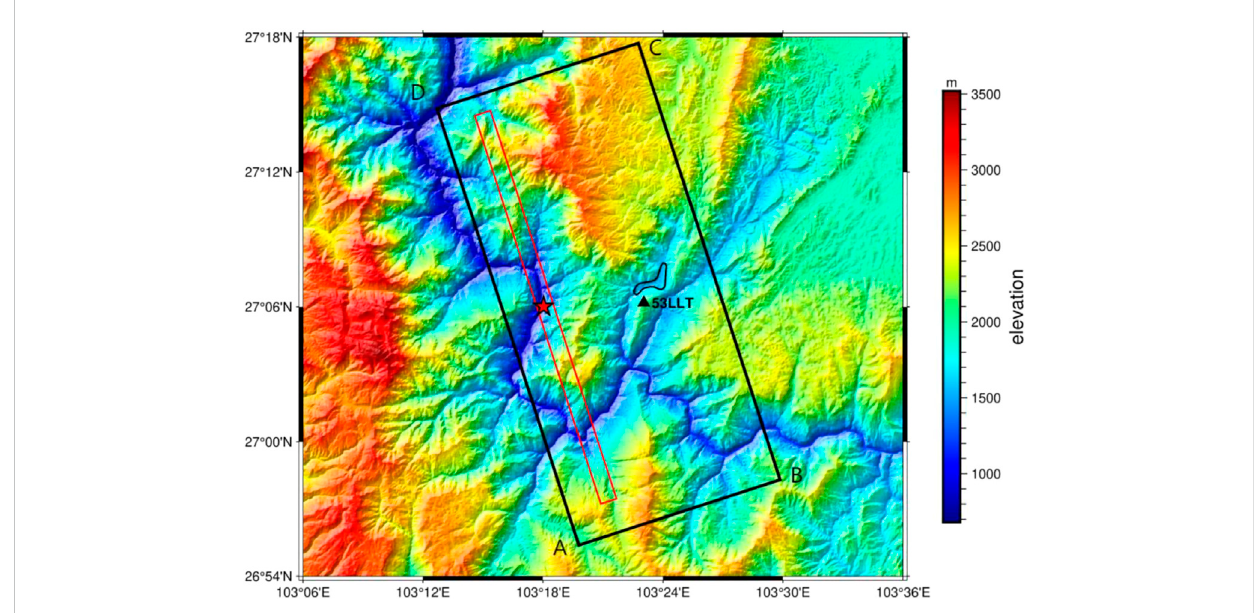
FIGURE 2 Map displaying the source location of the M6.5 Ludian earthquake. The area within the black rectangular outline is the study area. The red rectangular outline is the projection of the rupture fault location of the Ludian earthquake in Yunnan provided by the USGS. The red star denotes the epicenter location provided by the USGS. The black outline denotes the location of the Longtoushan town.